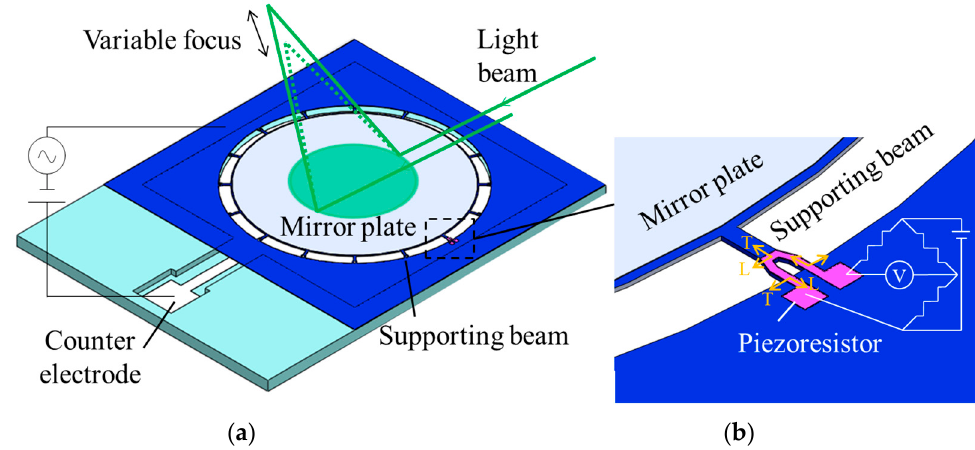
Figure 1. Schematic diagrams of the varifocal mirror with piezoresistive focus sensor. ( a ) Whole view of the varifocal mirror, ( b ) magnified of the piezoresistor part.